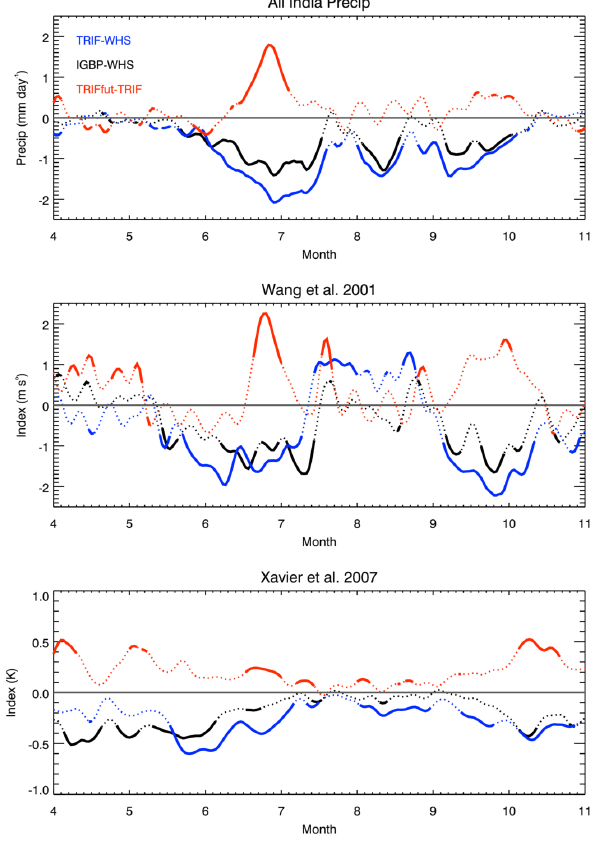
Fig. 5. Differences in the seasonal cycle of (top panel) all India precipitation, (middle) Indian monsoon index of W01, and (bottom panel) the index X07. Differences are presented as (black) IGBP – WHS, (blue) TRIF – WHS, (red) TRIFfut – TRIF. Unbroken seg- ments represent times of year when the difference is statistically significant at the 5% level based on a student’s t-test, while dotted segments are not